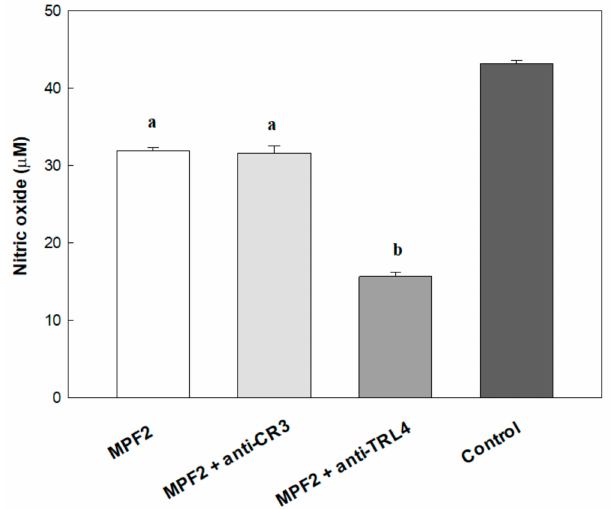
Figure 4. Nitric oxide (NO) production in the antibody neutralisation assay. RAW264.7 cells were pre-incubated with antibodies of the receptors for 2 h before stimulation with MPF2. LPS was used as the positive control. Data are presented as mean ± standard deviation. Different letters a,b indicate a significant difference ( p < 0.01) between polysaccharides (MPF2), MPF2 + anti-CR3 Ab, and MPF2 + anti-TLR4